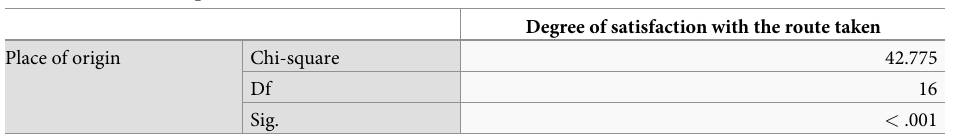
Table 7. Pearson chi-square